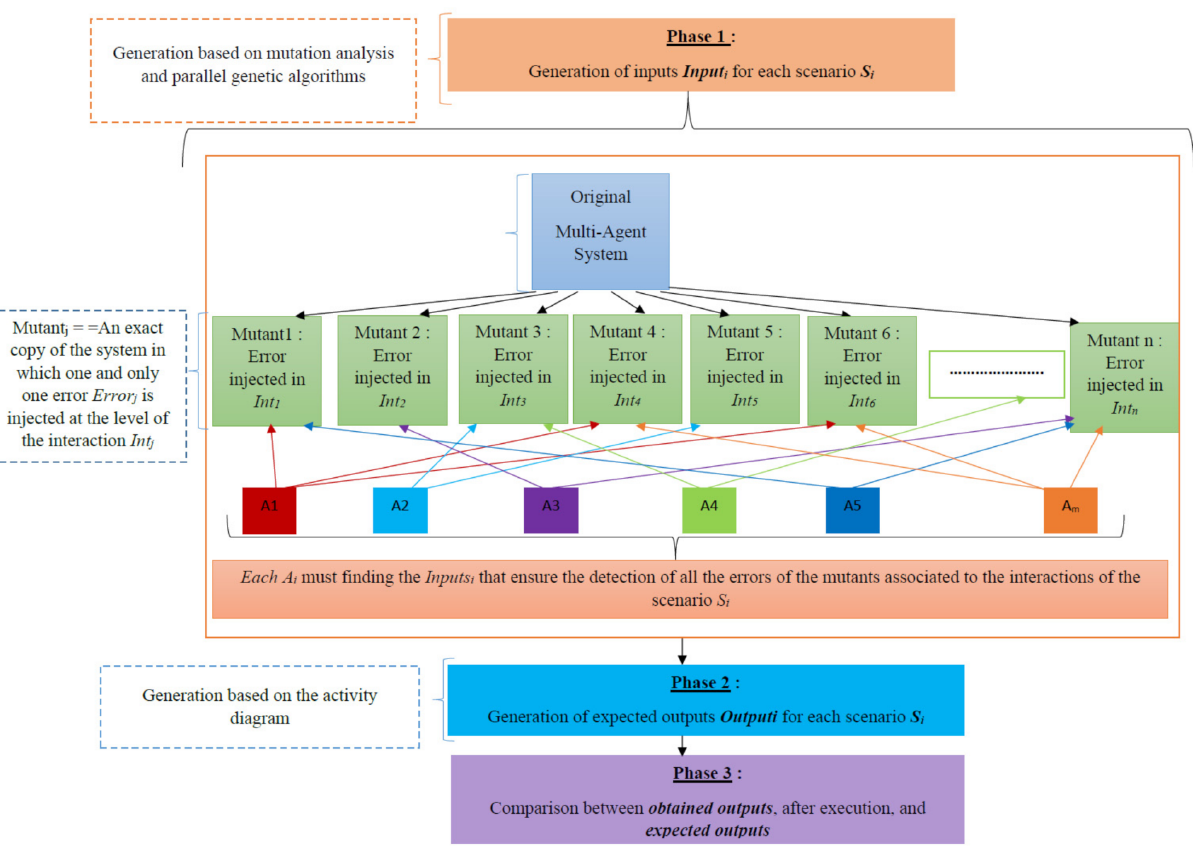
Figure 1. The phases of the proposed